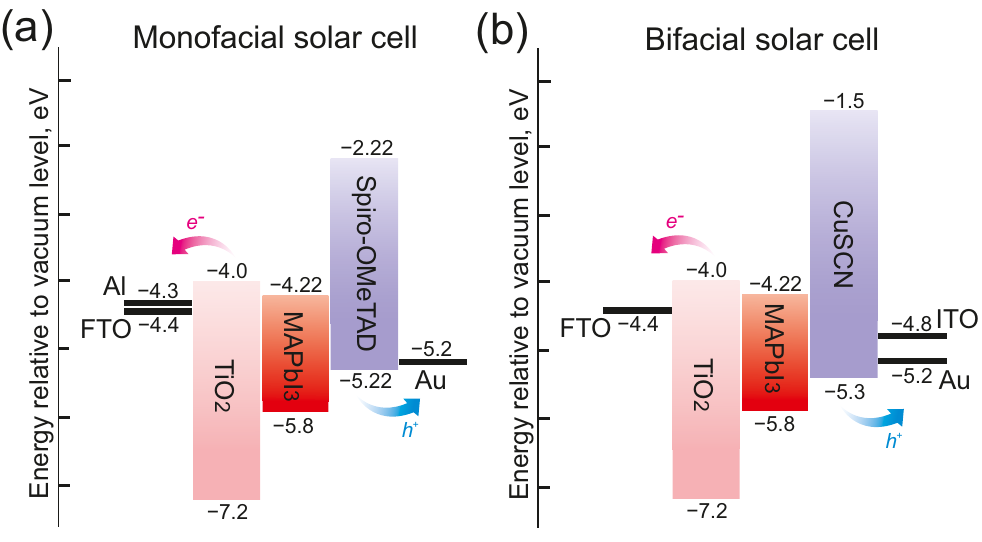
Figure 2. Band diagram of PSCs and the principle of charge separation: ( a ) Band diagram of monofacial PSCs. ( b ) Band diagram of bifacial